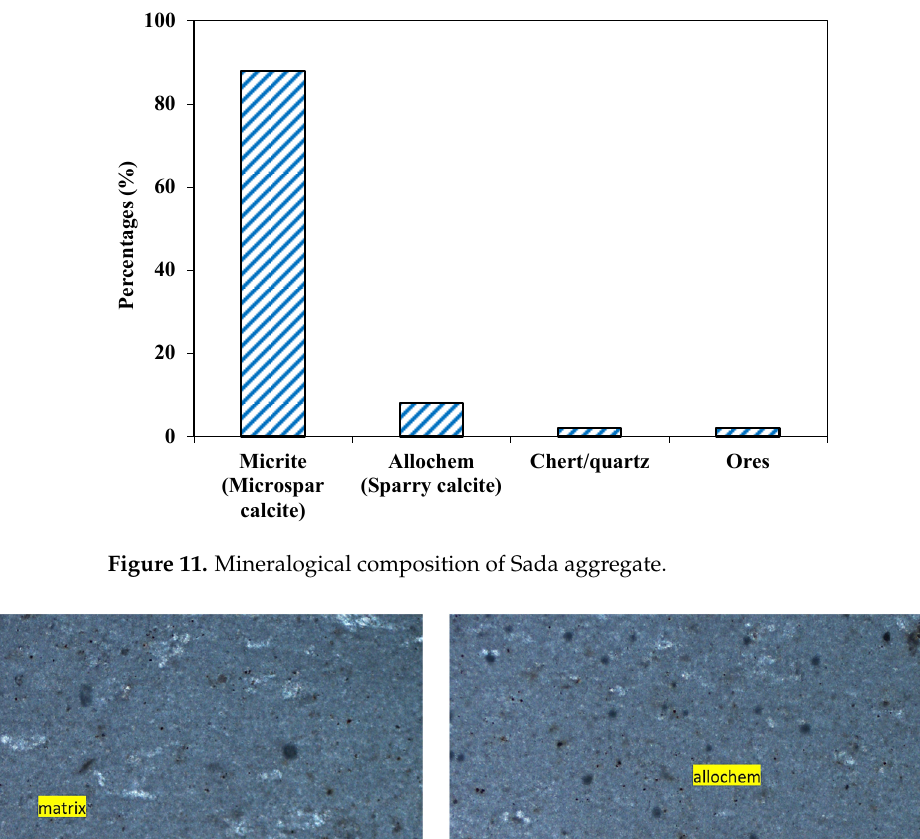
Figure 10. Photomicrographs of calcareous dolostone from Swabi area showing dolomite, calcite, quartz and calcite veins cross cutting the rock.